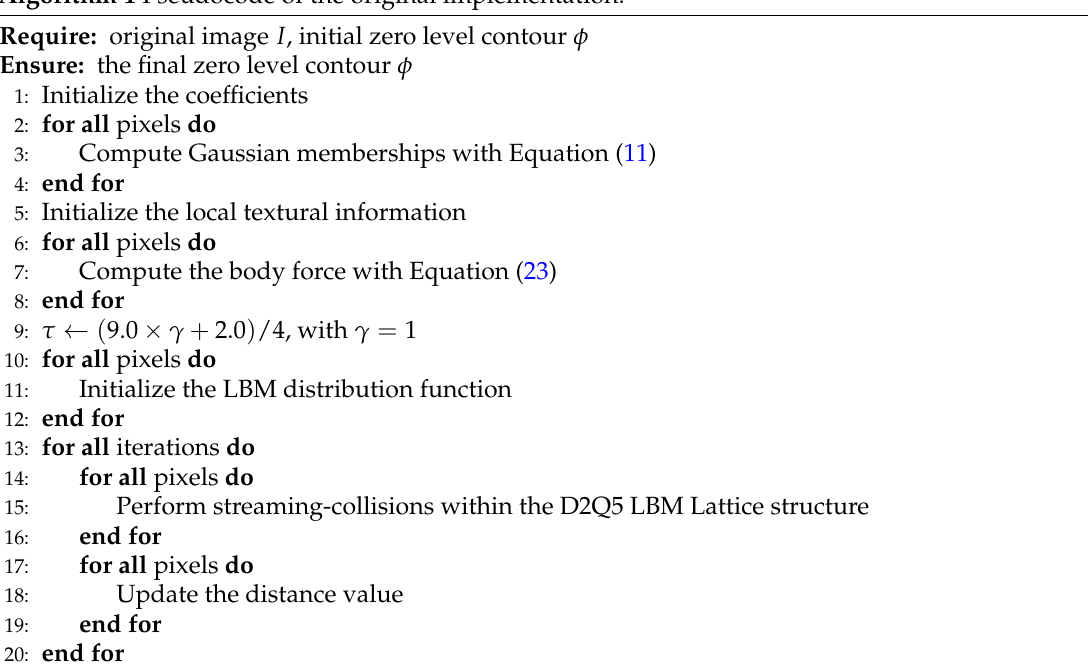
Algorithm 1 Pseudocode of the original